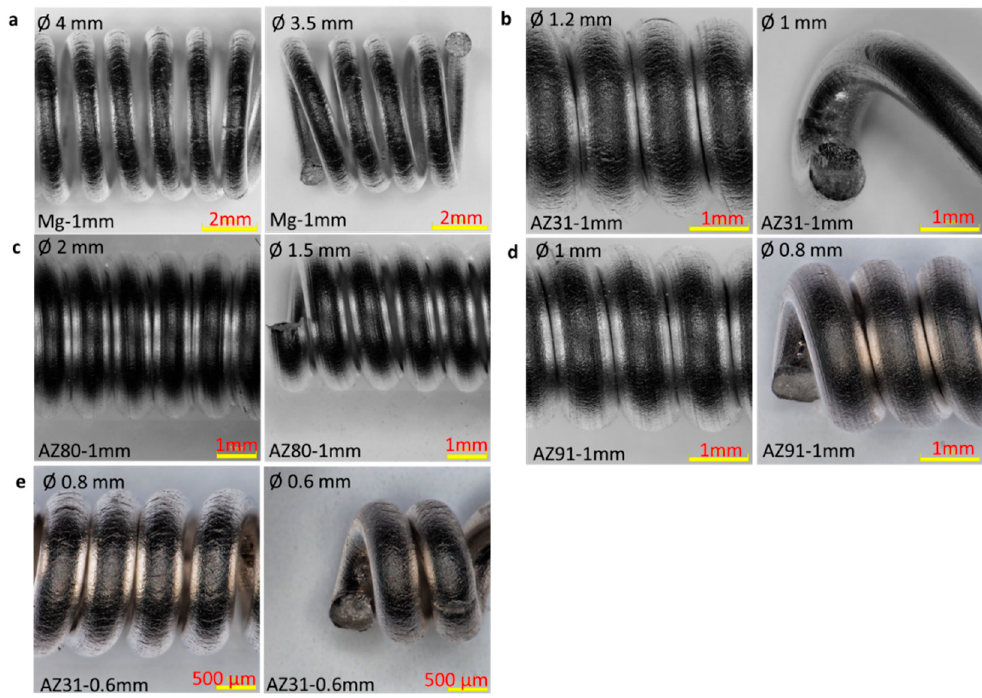
Figure 6. Macro pictures of the wrapped wires (left picture: one coil diameter setting before fracture, and right picture: coil diameter at material failure) for ( a ) Mg-1mm; ( b ) AZ31-1mm; ( c ) AZ80-1mm: ( d ) AZ91-1mm; and ( e ) AZ31-0.6mm; note the varying magnifications for improved surface visibility.